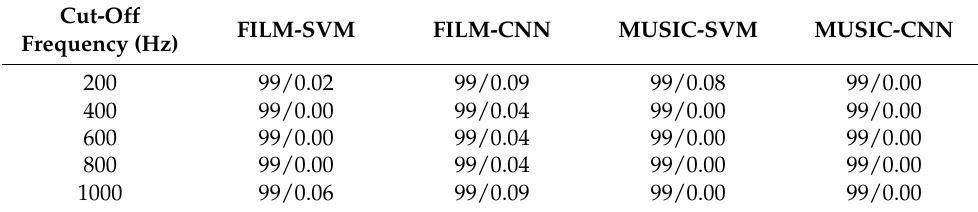
Table 4. ACC and FAR of the 2nd model with various f cof